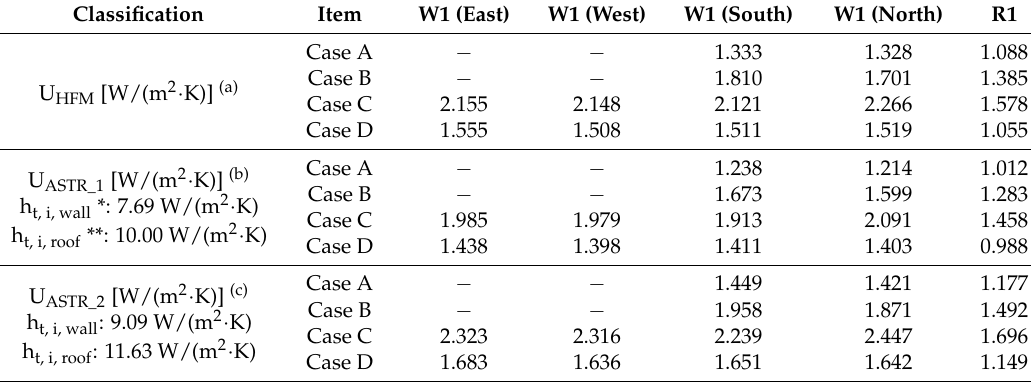
Table 6. U-value in situ measurement result according to the application of the indoor total surface heat transfer coefficient. ( a ) U HFM (ISO 9869); ( b ) U ASTR_1 (ISO 6946); ( c ) U ASTR_2 (Korea Energy Savings Design Standard).